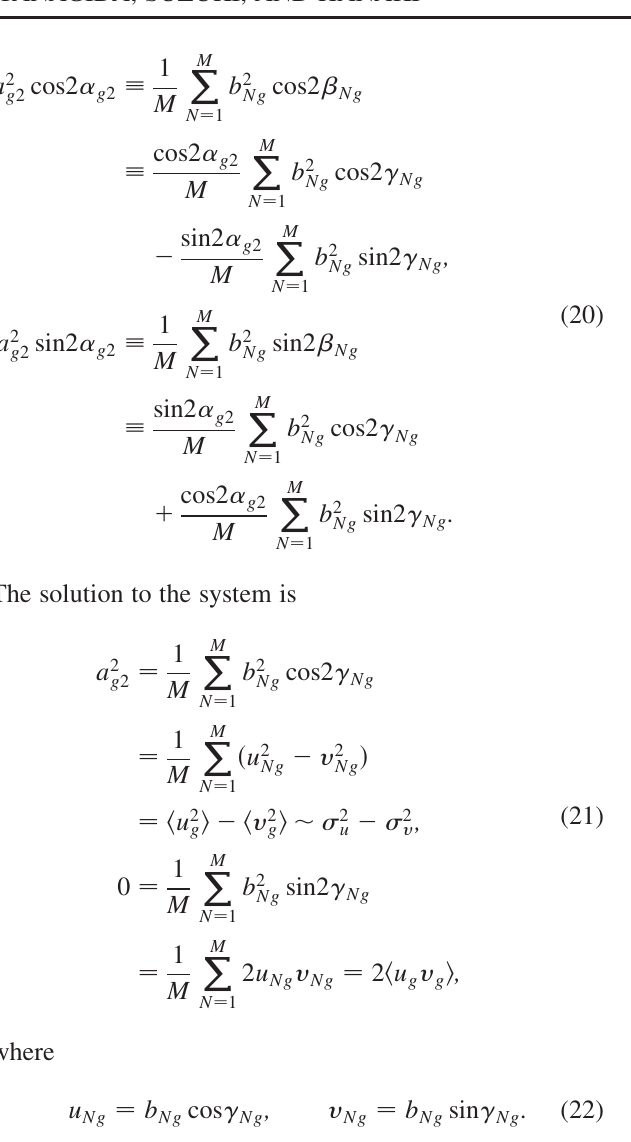
FIG. 4. Three examples of beam charge distributions with equivalent second-order relative moments when a 2 (cid:4)= 3 . Three parameters of ð (cid:11)